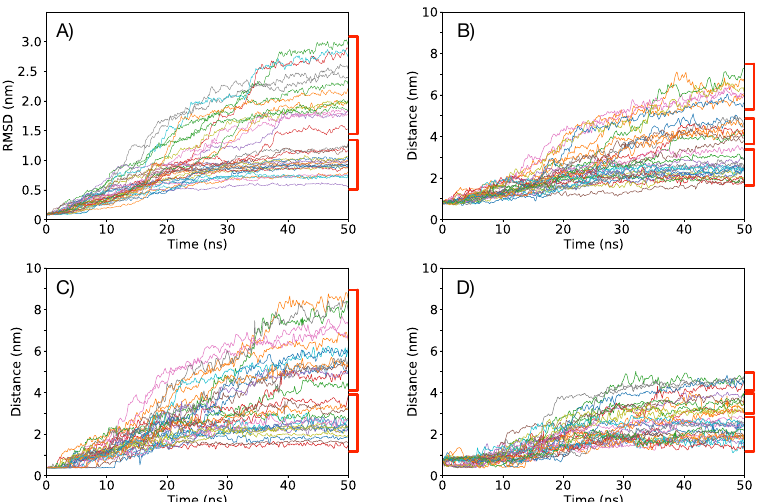
Figure 7. RMSD and measured distances of the VSD for the selected 34 replicas of Box 2 under a (cid:126) E = 0.2 V/nm for 50 ns. ( A ) RMSD as a function of time; ( B ) distance as a function of time between GLU 87 and PHE 135; ( C ) distance as a function of time between TRP 122 and ALA 101; ( D ) distance as a function of time between GLU 87 and ARG 165. Red brackets indicate groups of trajectories, suggesting possible clusterization of final VSD